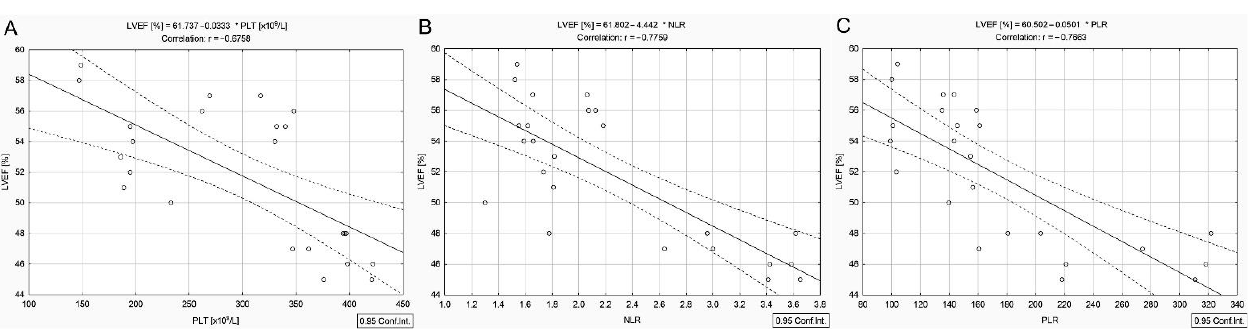
Figure 5. Correlations between LVEF and absolute platelet count ( A ), NLR ( B ), PLR ( C ) in differen- tiated thyroid cancer patients with type 2 diabetes mellitus.